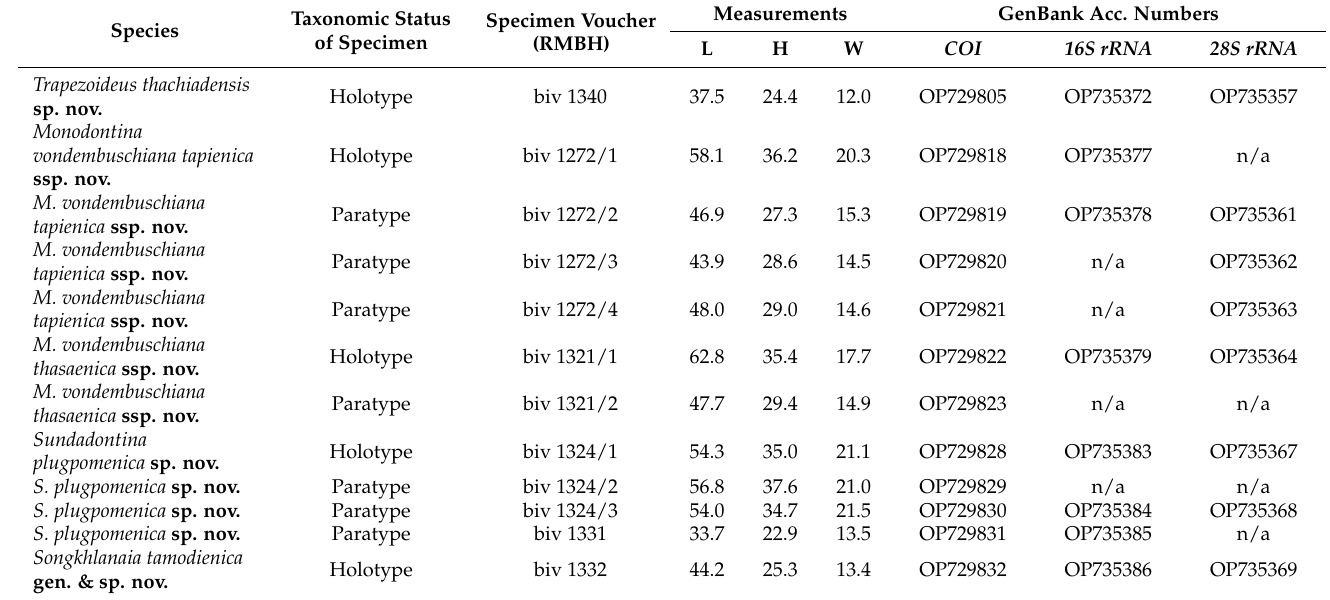
Table 1. Shell measurements and GenBank sequence accession numbers for the holotypes and selected paratypes of the new freshwater mussel taxa (Unionidae) from Southern